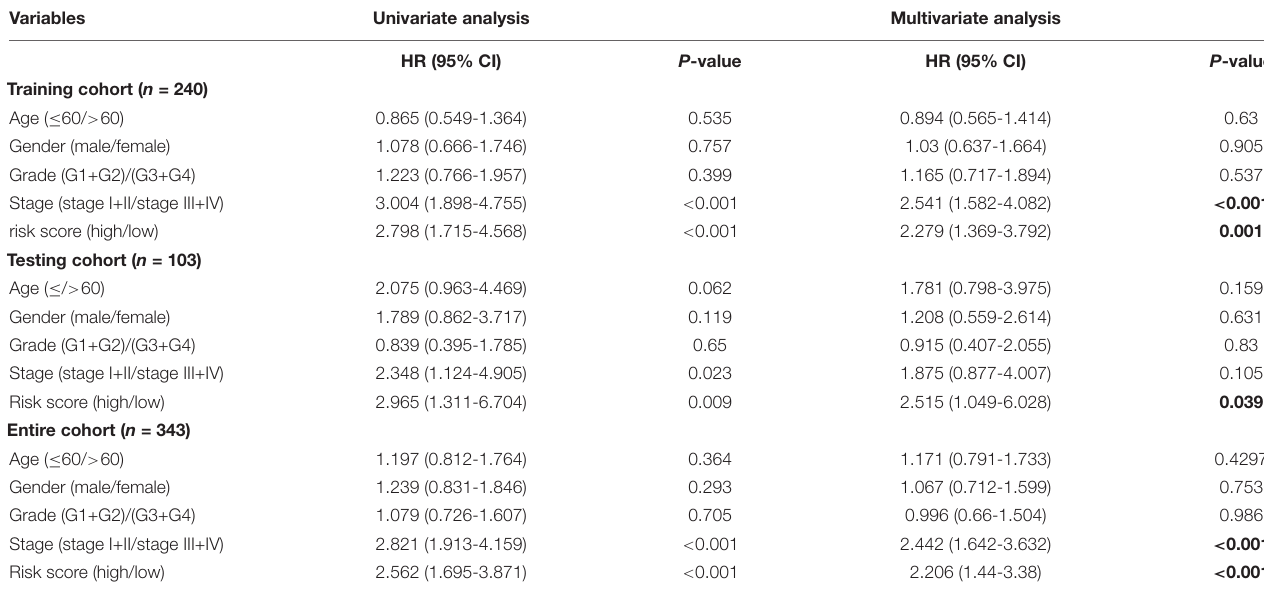
TABLE 3 | Univariate and multivariate Cox regression analyses of the risk score model and clinical